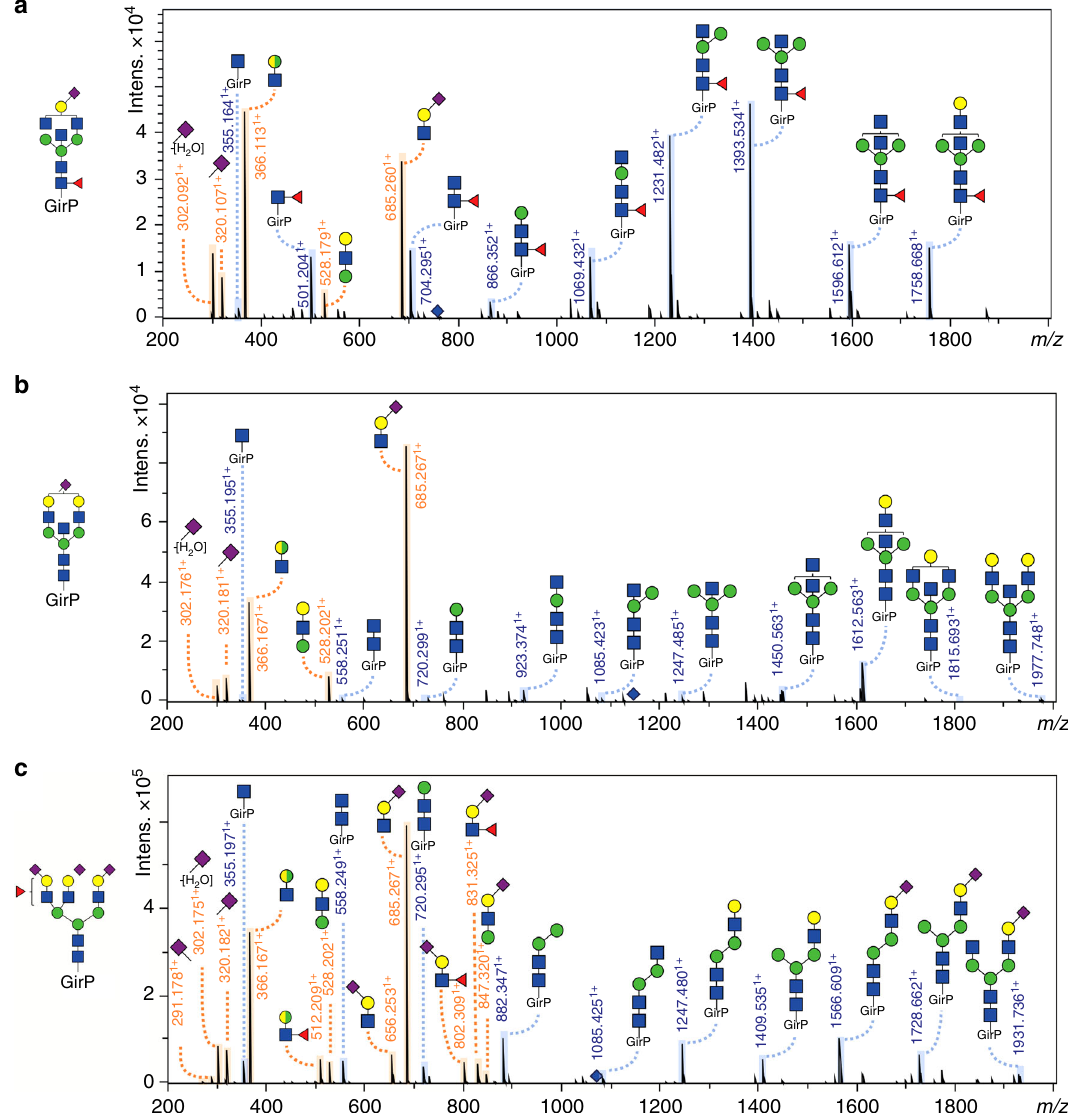
Fig. 3 CE-ESI-MS/MS fragmentation spectra of derivatized and labelled N -glycans from TPNG. The following precursor ions were fragmented: a 760.960 3 + (H4N5F1S 2,6 1), b 1148.939 2 + (H5N5S 2,6 1) and c 1072.076 3 + (H6N5F1S 2,3 1S 2,6 2). The Y-ion fragmentation pattern is annotated in blue and the B-ion fragmentation pattern is annotated in orange. Blue diamond: precursor ion, blue square: N -acetylglucosamine, green circle: mannose, yellow circle: galactose, red triangle: fucose, right pointing pink diamond: α 2,6-linked N -acetylneuraminic acid, left pointing pink diamond: α 2,3-linked N - acetylneuraminic acid, GirP: Girard ’ s reagent P label. *The presence of an antennary fucose in combination with an α 2,6-linked sialic acid is likely, for a large part, due to fucose migration during MS analysis